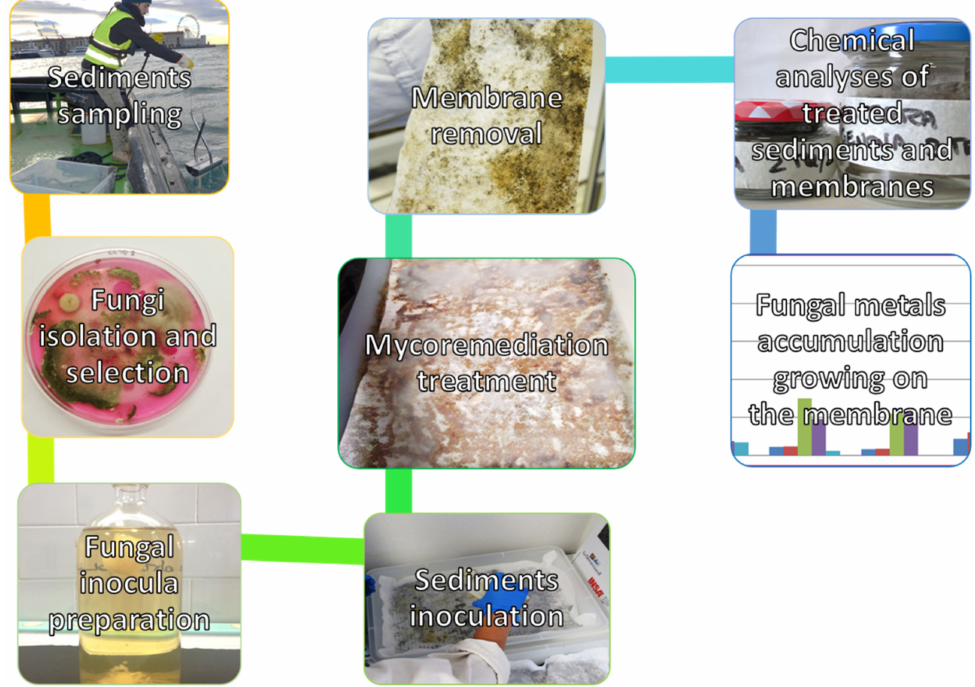
Figure 1. The sequence represents the main steps of the mycoremediation protocol developed and employed during the SEDITERRA